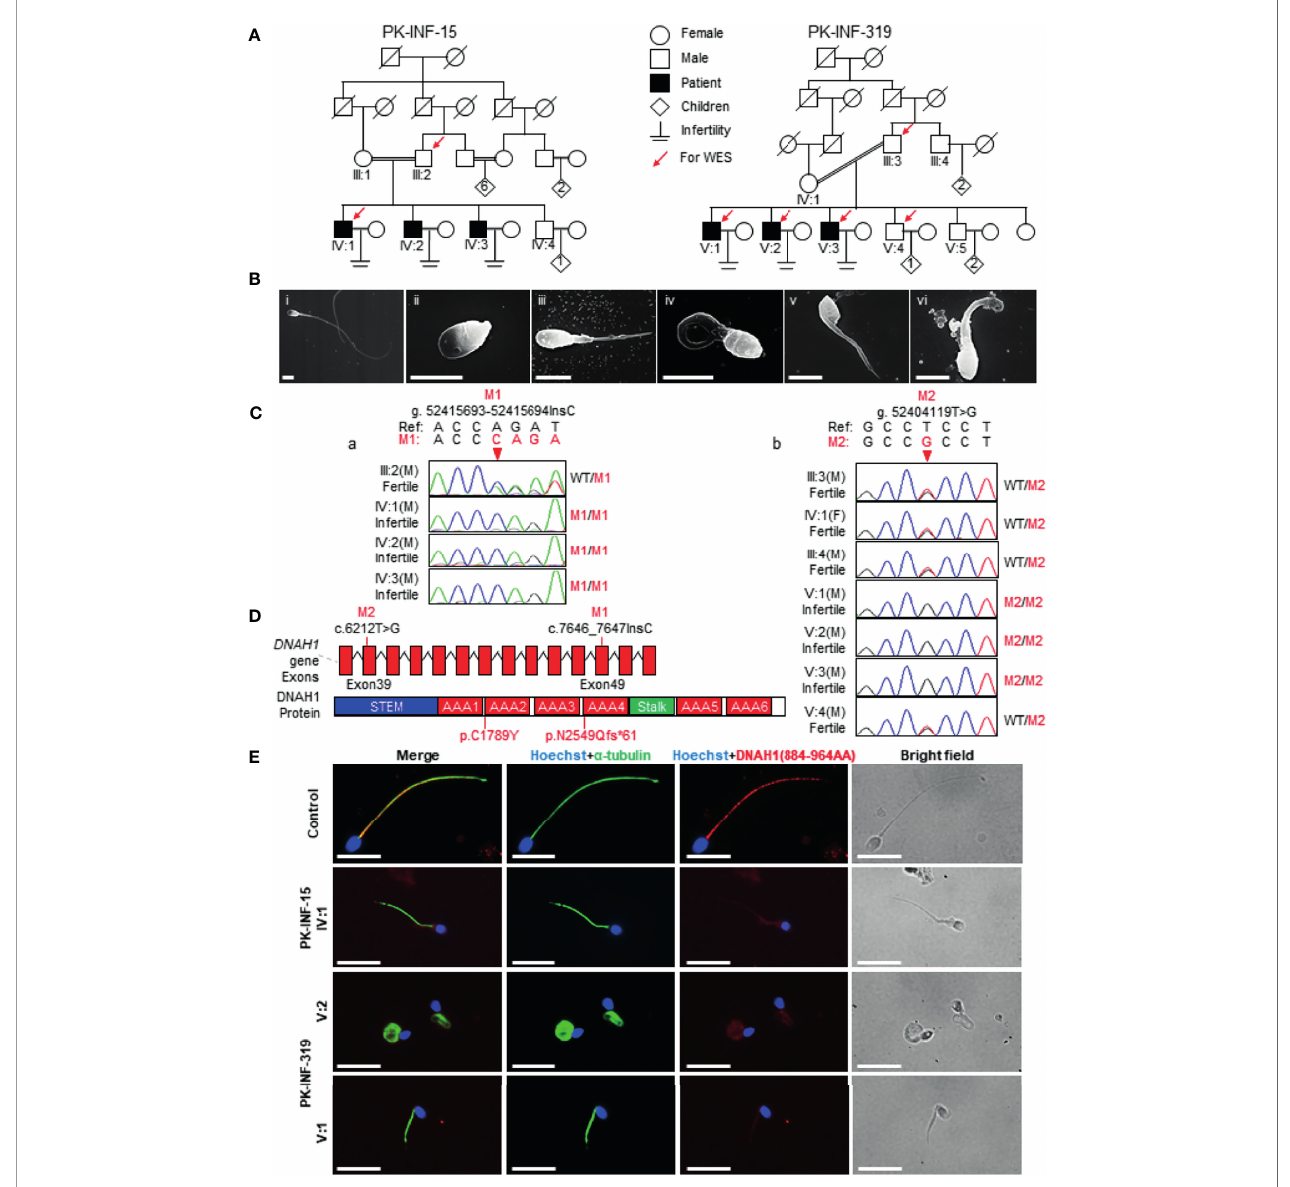
FIGURE 1 | Recruitment of infertile families displaying multiple morphological abnormalities of sperm fl agella phenotype. (A) Two consanguineous Pakistani infertile families (PK-INF-15 and PK-INF-319), comprising six male patients, were recruited. Male individuals are represented by squares, while female individuals were indicated with a circle. Diamonds indicate offspring, and the numerals inside designate the number of offspring. Solid squares are used to indicate patients, slashes represent deceased family members, and parallel slash lines specify consanguineous marriages. The red arrows indicate the members selected for whole-exome sequencing. (B) Scanning electron microscopy of sperm control (i) and from patients [PK-INF-319], V:1 (ii, ii, and iv) and V:2 (v and vi)] displayed various defects of fl agella, including absent, short, coiled, and irregular calibers. Scale bar, 10 um. (C) Chromatograms representing the segregation of DNAH1 mutations in available members from families (a) PK-INF-15 and (b) PK-INF-319. The red arrows show the genomic position of DNAH1 mutations. (D) An illustrative representation of DNAH1 gene and subsequent protein structure showing the identi fi ed mutation positions. (E) No DNAH1 signals were found on paraformaldehyde- fi xed sperm from a patient stained against DNAH1 and a -tubulin, while intact DNAH1 signals were observed on sperm obtained from a healthy control. Scale bar, 10